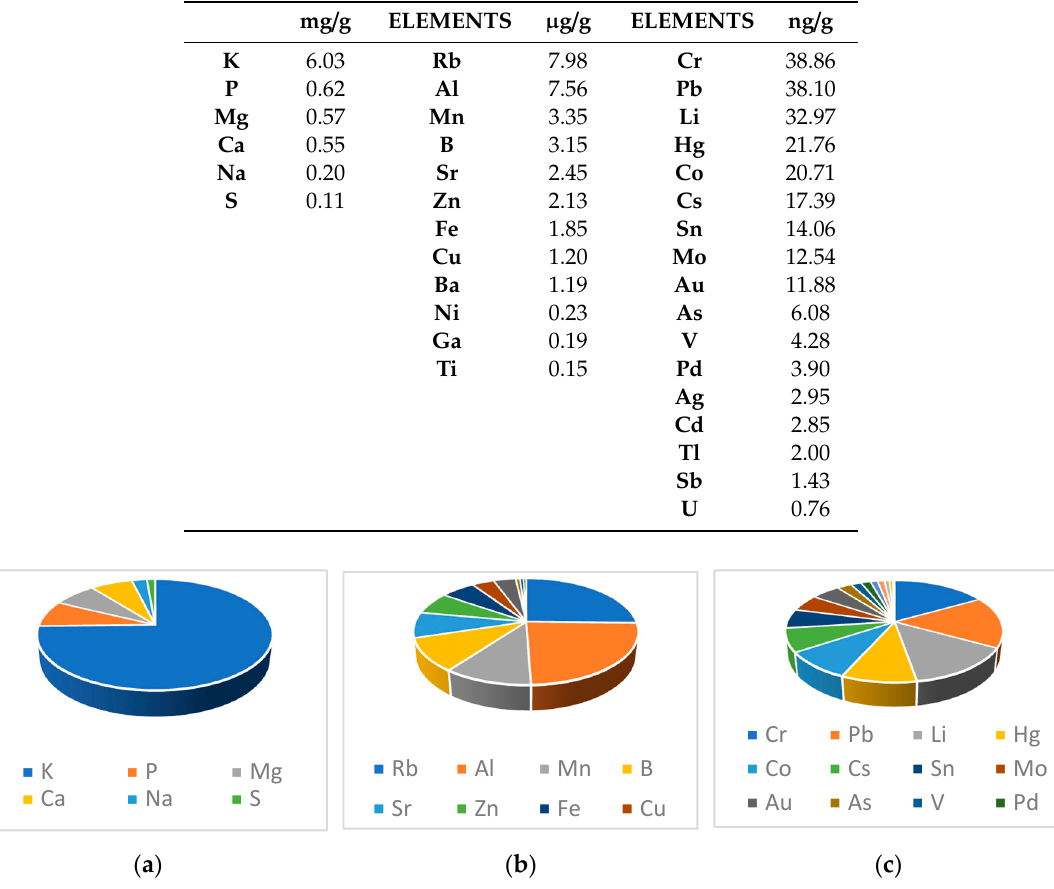
Table 9. Elemental constituents in the extract referred to 1 g of initial spent coffee.